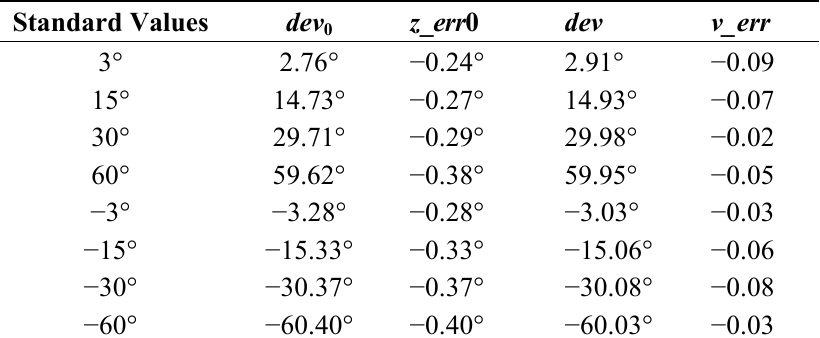
Table 1. The tilt angle measurement data.